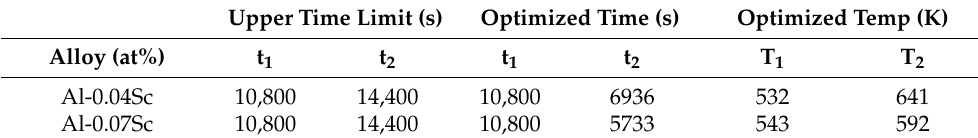
Table 6. Example Bayesian optimization limits and optimized results.